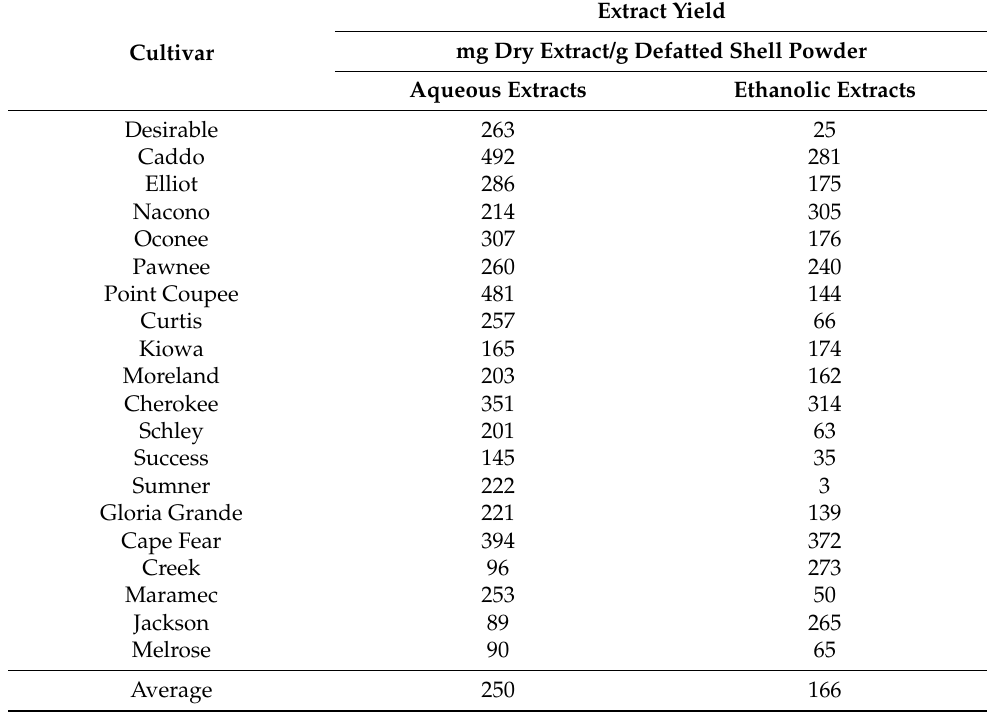
Table 1. Yield of pecan shell extracts from 20 different